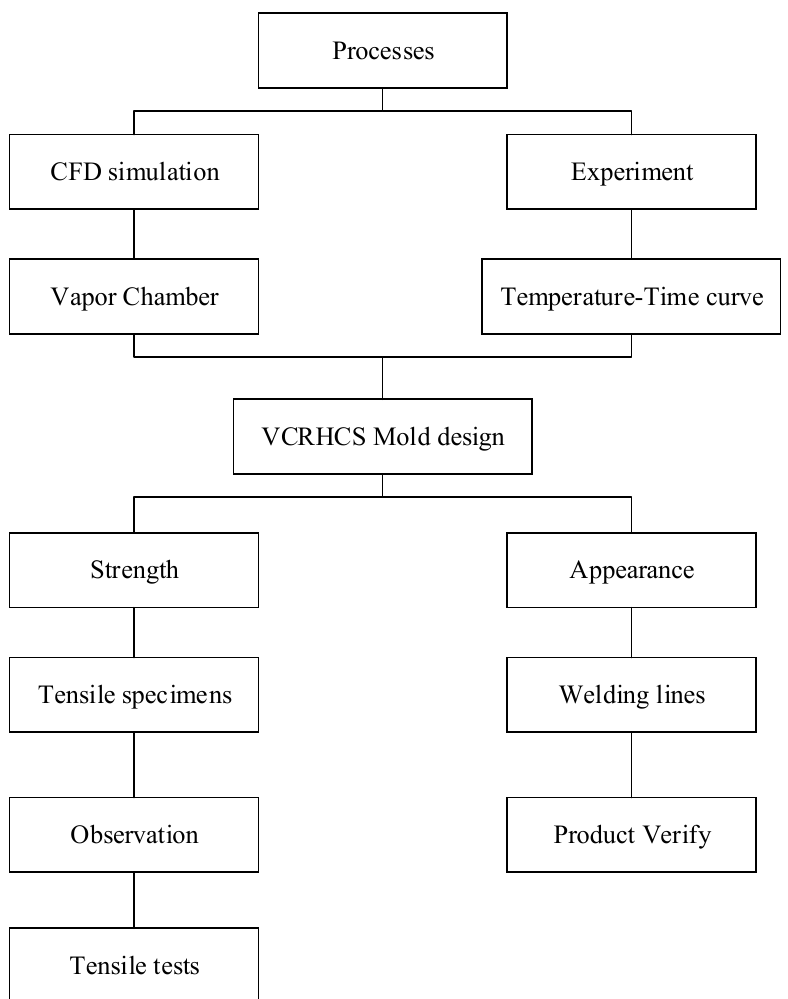
Figure 1. Experimental architecture diagram.